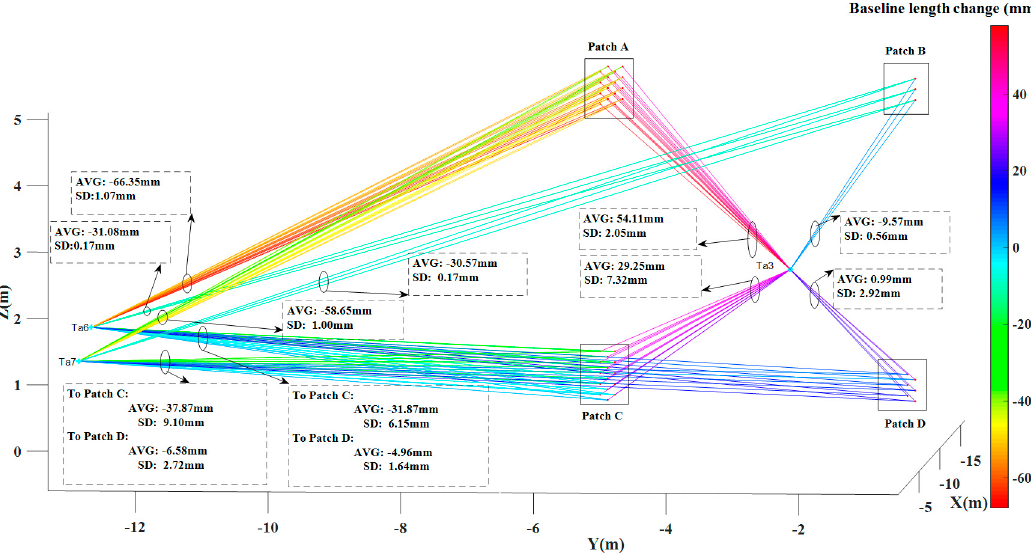
Figure 14. Baseline length changes (from target points to virtual brick centre points). The quantitative results are summarized in Table 1.